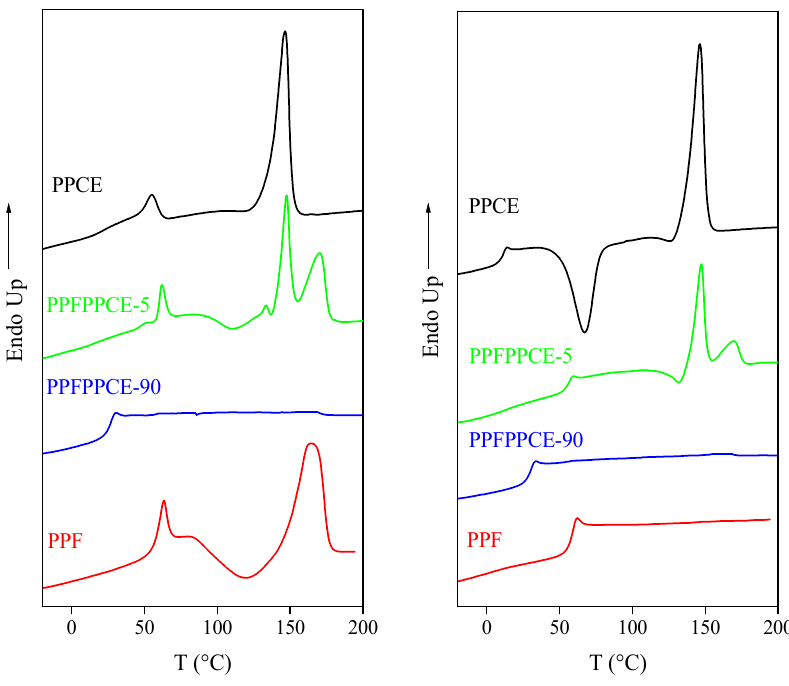
Figure 3. Calorimetric curves of PPF, PPCE, PPFPPCE-5, and PPFPPCE-90. Left: 1st scan; right: 2nd scan after quenching from the melt.